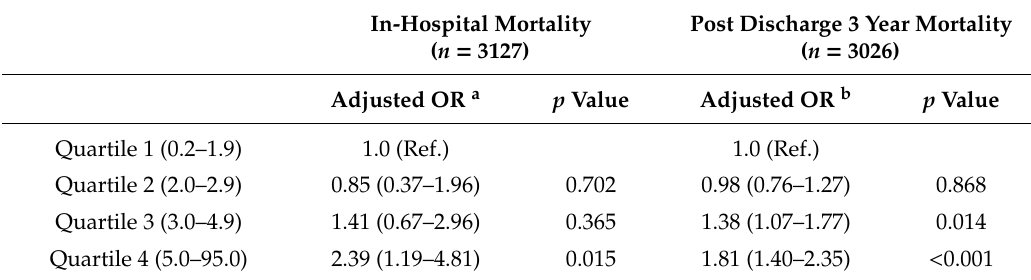
Table 4. Univariate and multivariate logistic regression analyses for all-cause in-hospital and post discharge 3-year mortality in HF patients subgroup analysis by aggravating factor. HF, heart failure; NT-proBNP, n-terminal brain natriuretic peptide; HFrEF, heart failure with reduced ejection fraction; HFmrEF, heart failure with mid-range ejection fraction; HFpEF, heart failure with preserved ejection fraction; BNP, brain natriuretic peptide; AA, aldosterone antagonist; BB, beta blocker; RASi, renin-angiotensin system inhibitor.